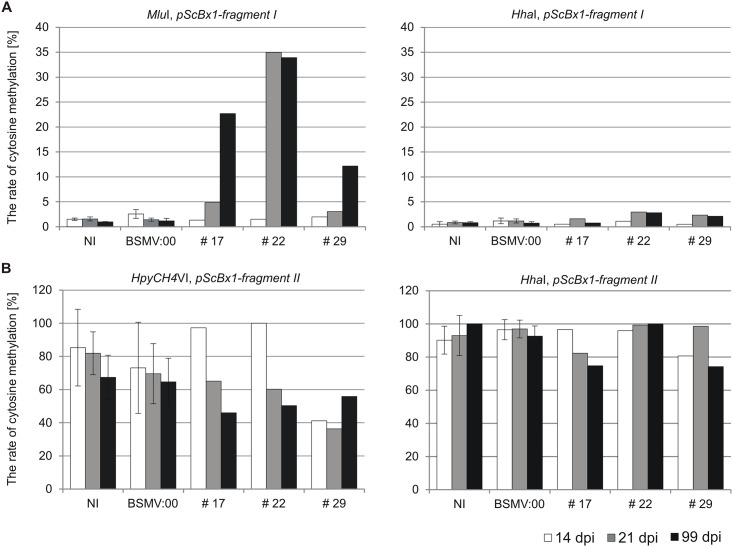
Rate of cytosine methylation in gDNA regions targeted with TGS vectors.Rate of cytosine methylation in sites recognized by MluI and HhaI in fragment I (A) and in sites recognized by HpyCH4IV and HhaI in fragment II (B) of ScBx1 promoter. NI—non-inoculated plants, BSMV:00 –plants inoculated with BSMV:α,β(-),γ(-) vector, #17, #22, #29 –plants inoculated with BSMV:α,β(pScBx1-fragment I),γ(pScBx1-fragment II) vector.